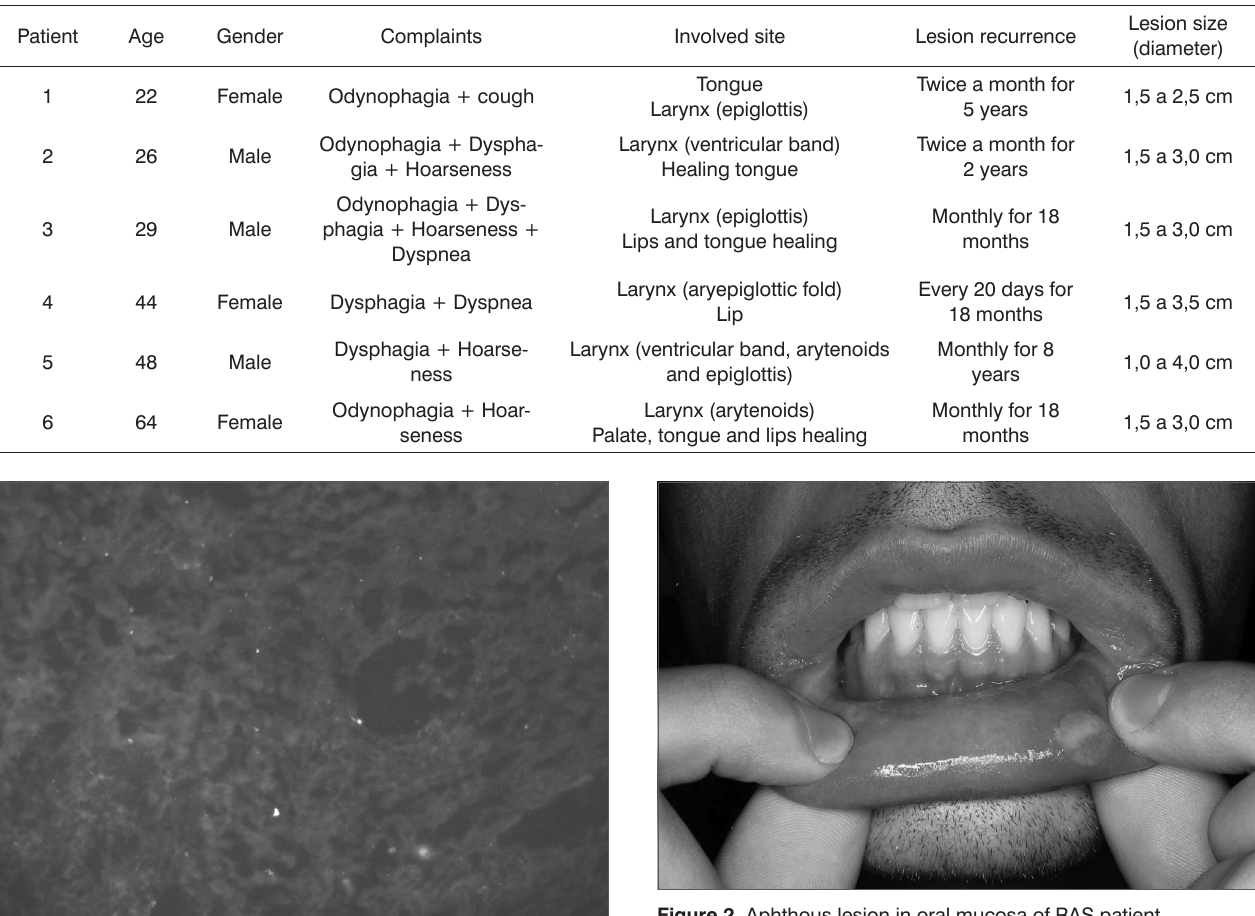
Figure 2. Aphthous lesion in oral mucosa of RAS